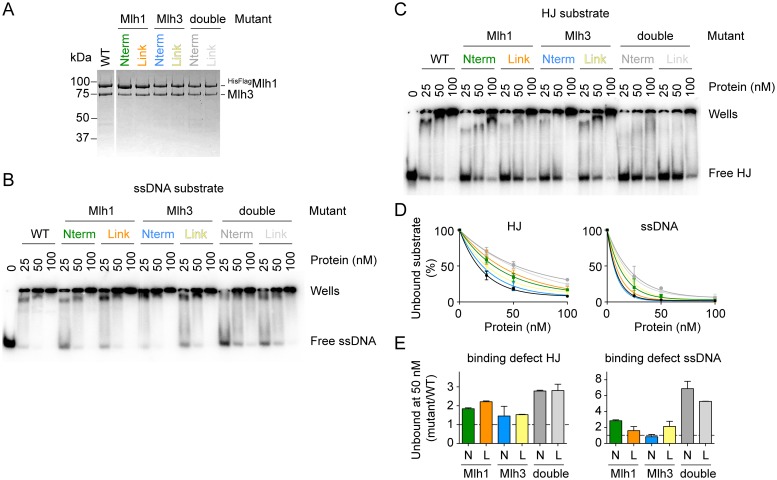
In vitro characterization of a selection of MutLγ DNA-binding mutants.A. Purification of MutLγ DNA-binding mutants. All complexes carried an N-terminal tag on Mlh1. The mutants are as follows: Mlh1-Nterm (K286E/R289E), Mlh1-Link (K393E/R394E) and Mlh3-Nterm (K316E/K320E/R323E), Mlh3-Link (K414E/K416E). A Coomassie-stained SDS-PAGE gel is shown. B. EMSA with MutLγ mutants using 1 nM end-labeled ssDNA substrate. C. EMSA of MutLγ mutants with 1 nM end-labeled HJ substrate. D. Quantifications of the free substrate in EMSA experiments from panels B and C. Error bars show the range from two independent experiments. E. The HJ and ssDNA-binding defects of the MutLγ mutants measured by the ratio of free substrate with mutant MutLγ divided by the free substrate with wild-type MutLγ at 50 nM protein. Error bars show the range from two independent experiments.